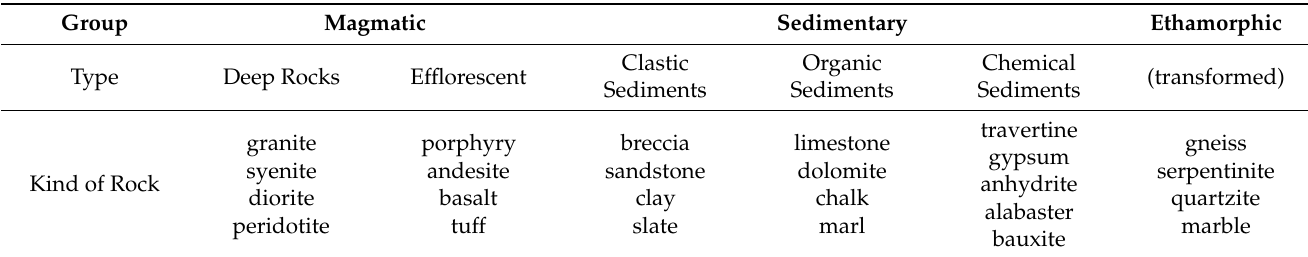
Table 1. Division of rocks by geological origin [58].